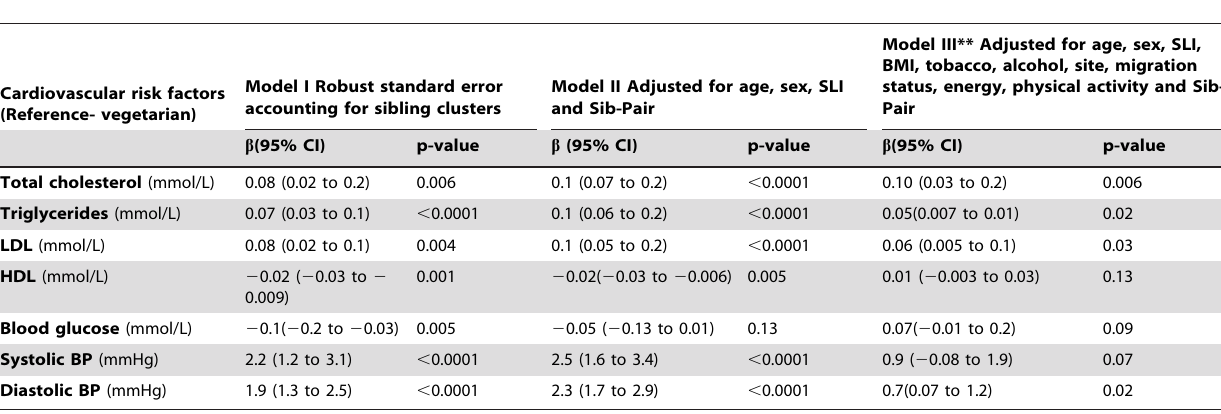
Table 3. Multivariate linear regression models* for cardiovascular risk factors of Indian Migration Study population comparing non-vegetarians with